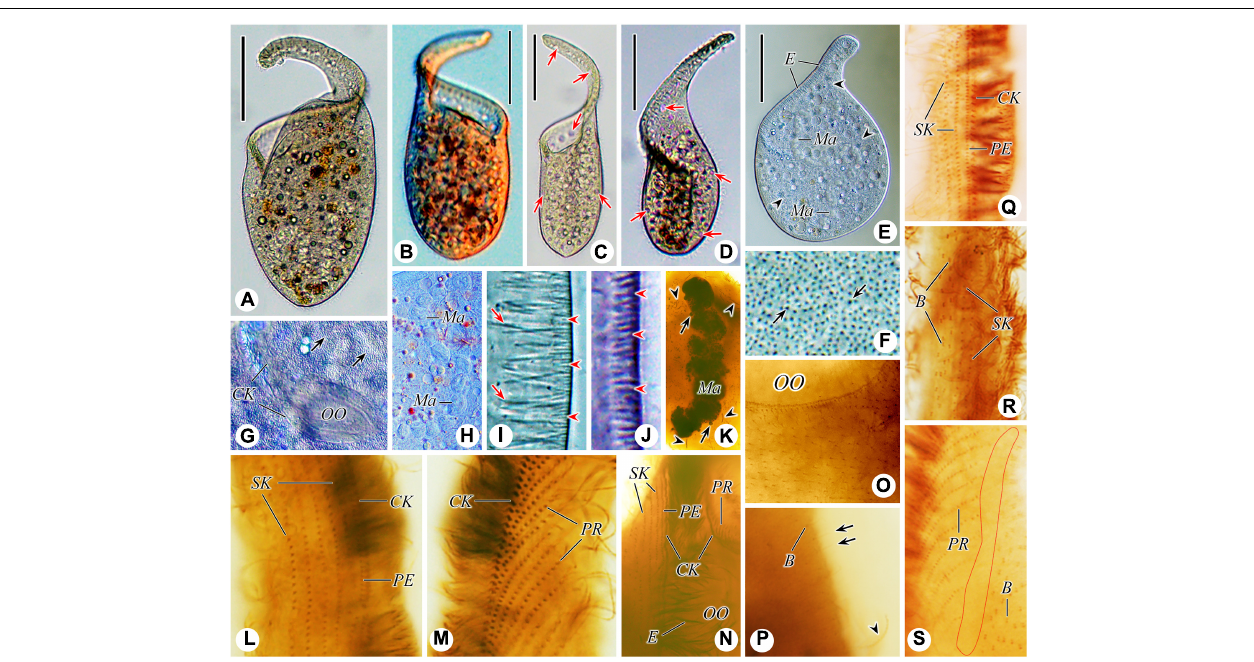
FIGURE 3 | Photomicrographs of Paradileptus elephantinus from life (A–J) and after protargol staining (K–S) . (A–D) Various individuals to show different body shapes; arrows indicate the contractile vacuoles. (E) To show the rod-shaped extrusomes regularly arranged in the proboscis and developing extrusomes scattered in the cytoplasm (arrowheads). (F) Cortical granules (arrows) underneath the cortex. (G) Detail of oral area showing the densely arranged cortical granules (arrows). (H) Detail of the moniliform macronucleus. (I) Tangential optical section of proboscis to show the elongated rod-shaped type I extrusomes (arrows) and short rod-shaped type II extrusomes (arrowheads). (J) Tangential optical section of cortex to show the oblong cortical granules (arrowheads). (K) Details of the macronucleus, micronuclei (arrows), and developing extrusomes (arrowheads). (L,M) Right (L) and left (M) views of the anterior regions of the proboscis of the same individual showing the perioral kinety, circumoral kinety, and recognizable somatic kineties. (N) Detail of proximal portion of oral apparatus. (O) Showing the loosely arranged somatic kinetosomes. (P) Left view of posterior portion of proboscis; arrows indicate the monokinetidal tails of dorsal brush with bristles; arrowhead marks a somatic cilium. (Q,R) Right view of the anterior (Q) and middle (R) regions of the proboscis. (S) Detail of the posterior portion of the proboscis; red circle indicates the glabrous area. B, dorsal brush; CK, circumoral kinety; E, extrusomes; Ma, macronucleus; OO, oral opening; PE, perioral kinety; PR, preoral kineties; SK, somatic kineties. Scale bars = 90 µ m (A,B,D,E) , 130 µ m (C)